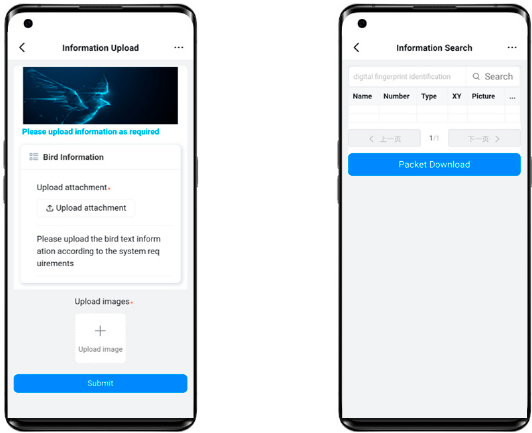
Figure 5. User upload and download interface.